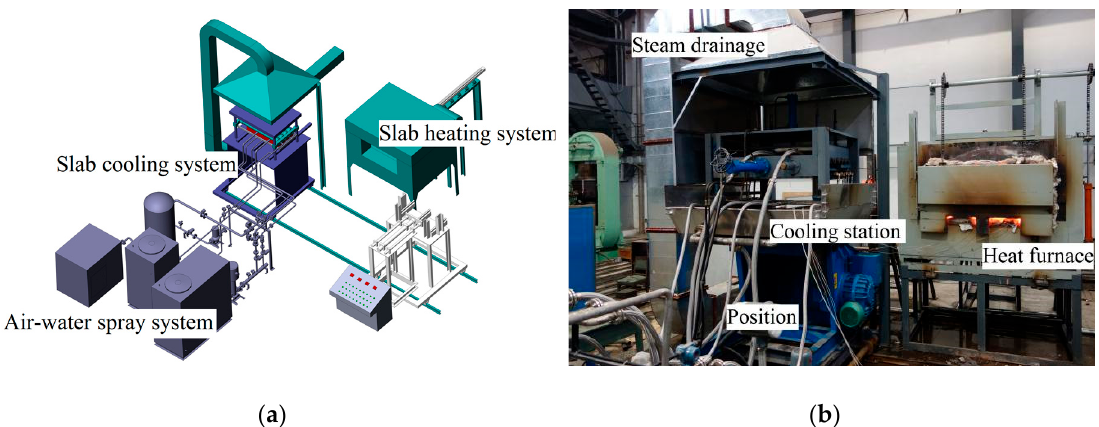
Figure 1. Schematic presentation ( a ) and equipment ( b ) of the experimental setup.